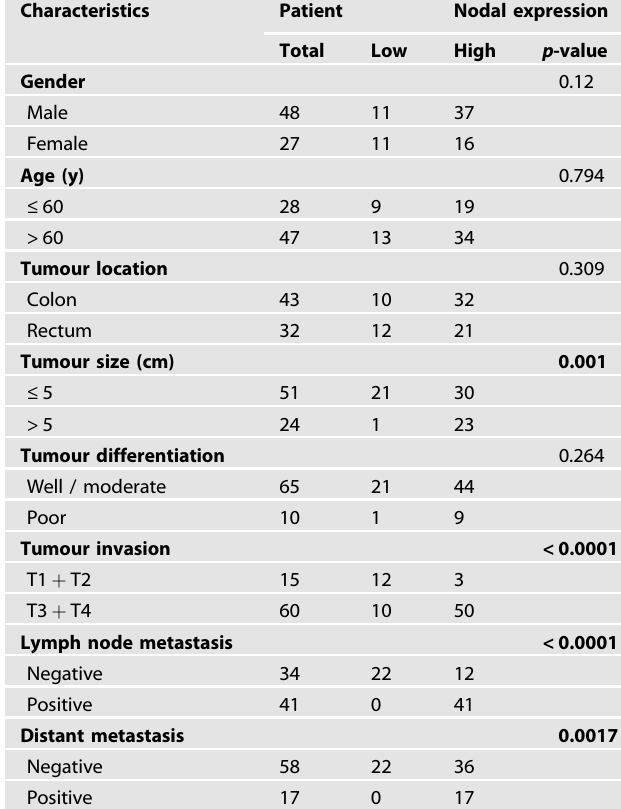
Table 1. Association of Nodal expression with clinicopathological data from